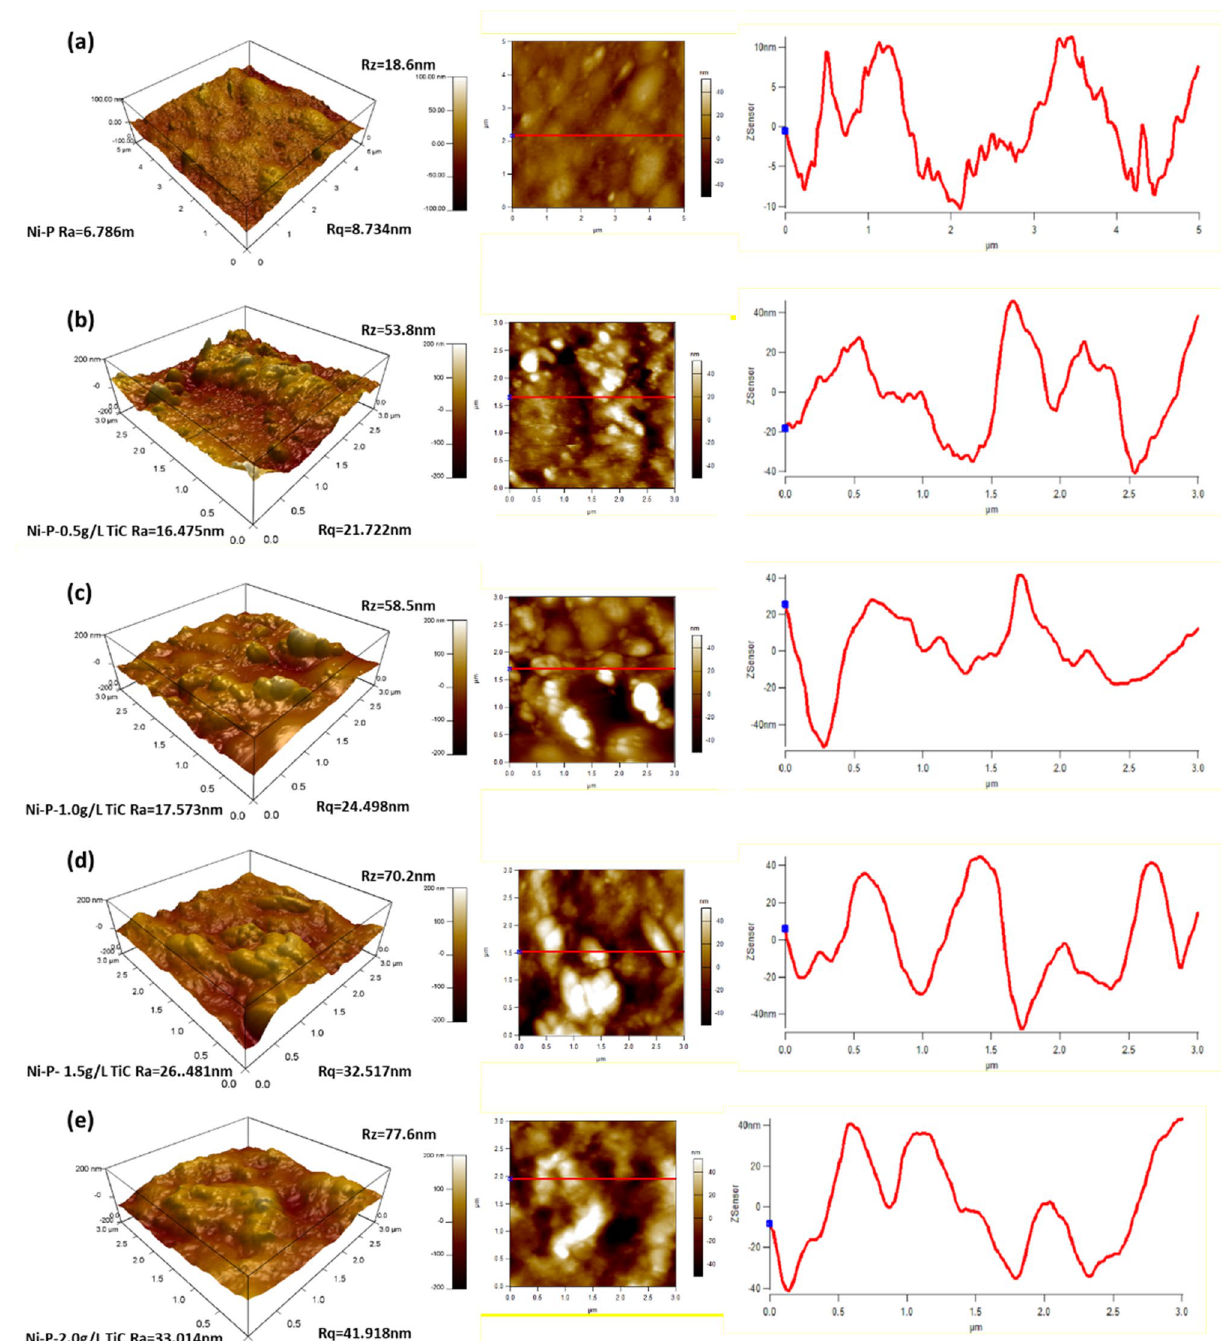
Figure 9. 3D-AFM micrograph along with their corresponding surface roughness profiles of the ( a ) Ni–P, Ni–P–TiC composite coatings ( b ) 0.5 g L −1 , ( c ) 1.0 g L −1 , ( d ) 1.5 g L −1 , and ( e ) 2.0 g L −1 of TiC